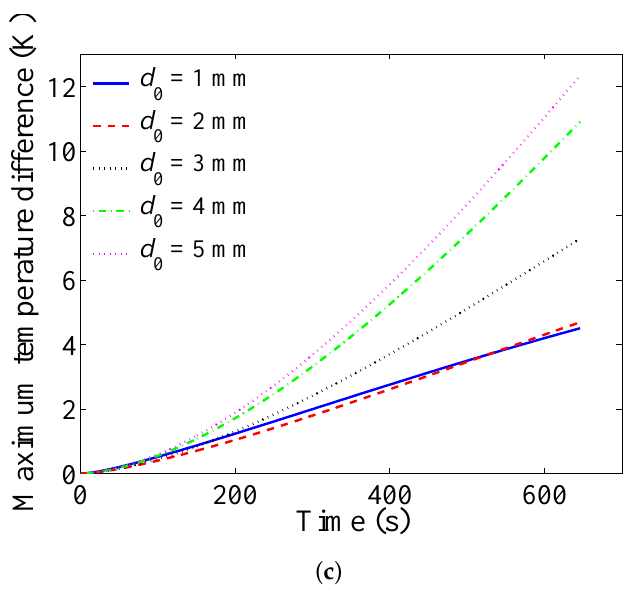
Figure 9. Comparison of the results for various cell spacings. ( a ) Flow rate in the cooling channel; ( b ) maximum temperature; ( c ) maximum temperature